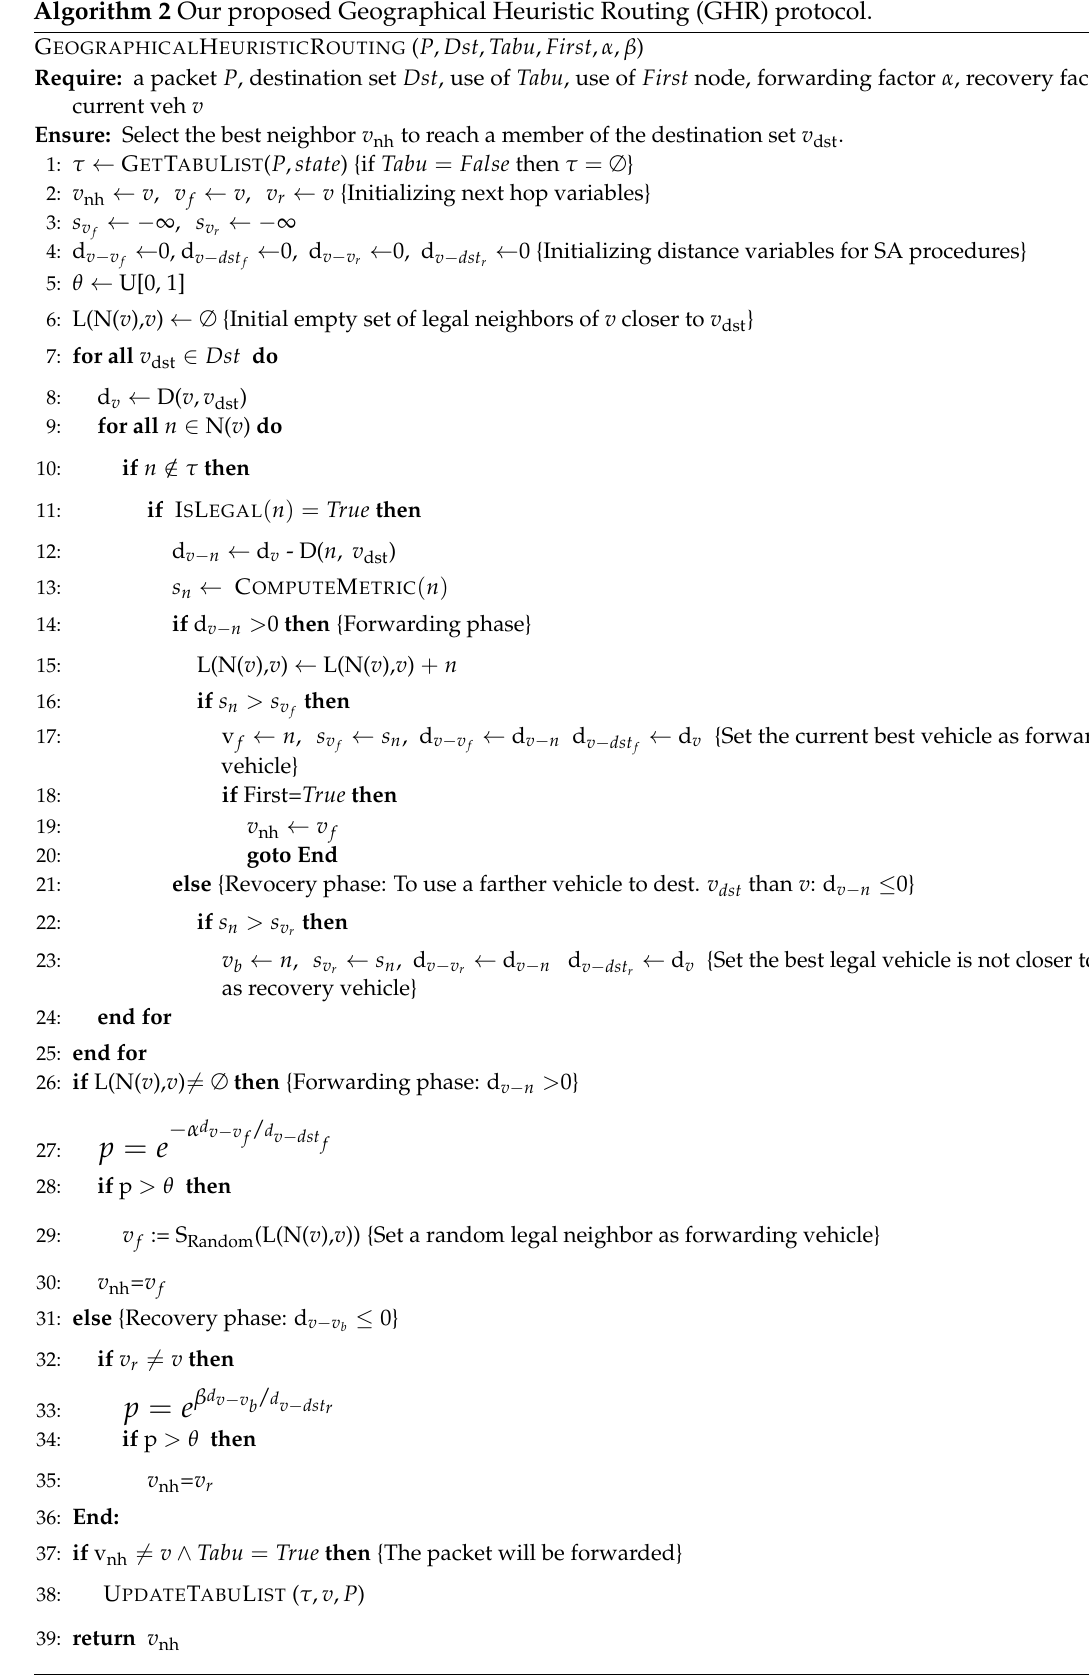
Algorithm 2 Our proposed Geographical Heuristic Routing (GHR) protocol. G EOGRAPHICAL H EURISTIC R OUTING ( P , Dst , Tabu , First , α , β